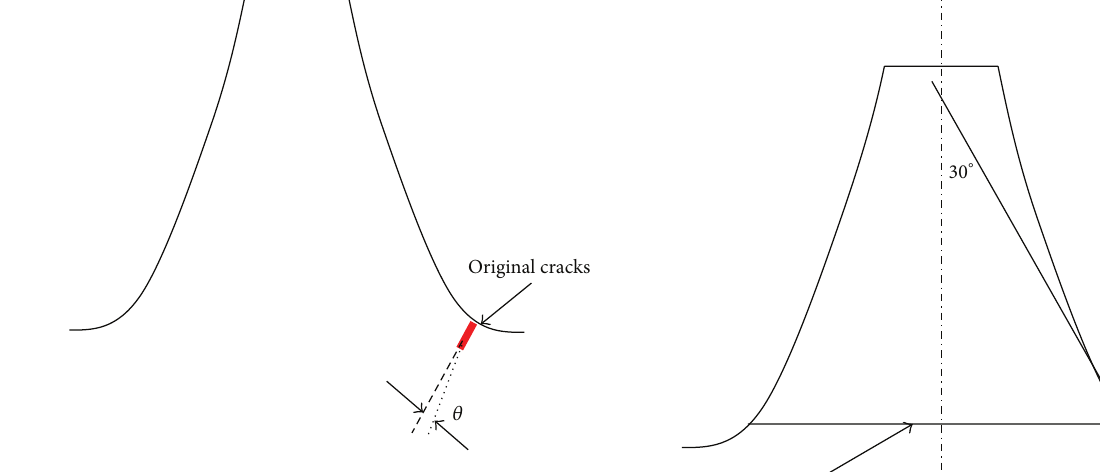
Figure 1: A sketch of pinion dedendum fatigue crack extension directions.